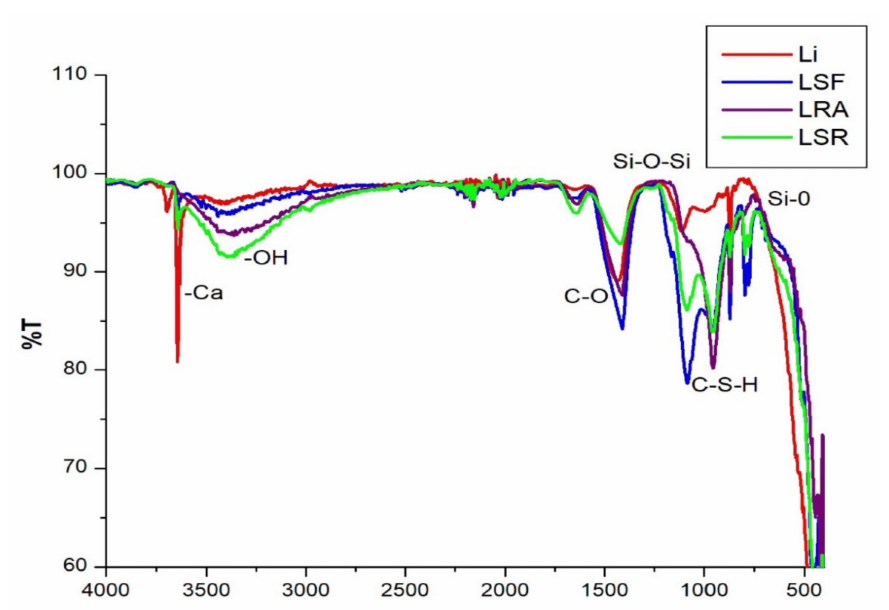
Figure 24. Comparison of all FTIR